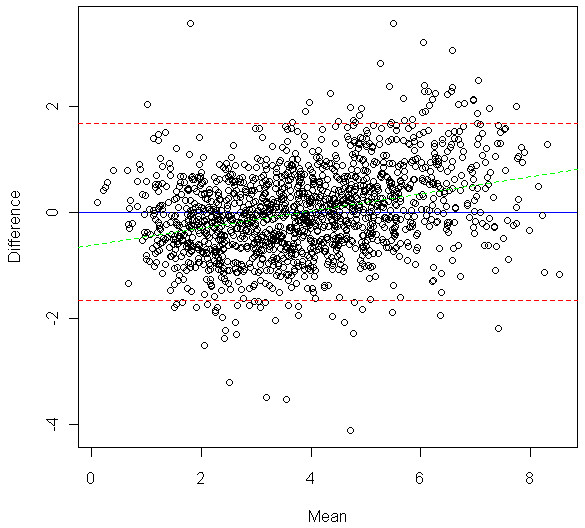
Bland-Altman plot of mean of Cumulus PD and ImageJ PD versus the difference between the two measurements. Blue solid line, Mean difference (0.019). Red dotted lines, Lower and upper limits of agreement (-1.66 and 1.69, respectively). Green dotted line, Line of best fit (slope = 0.161; intercept = -0.610).